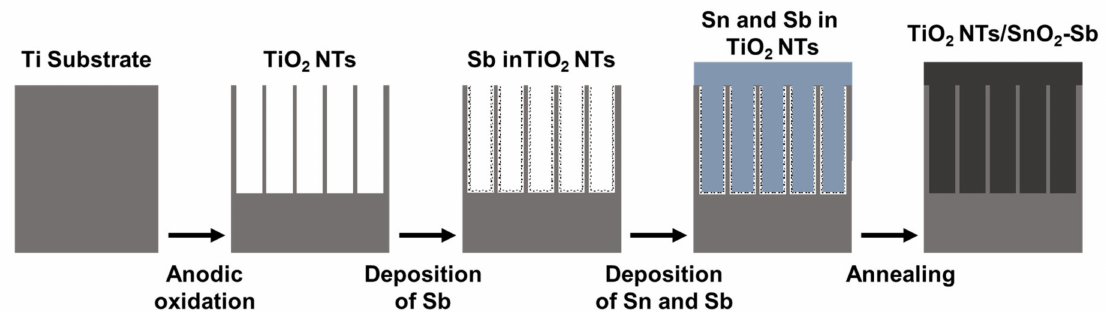
Figure 7. Schematic illustration of the vertically aligned nanotube